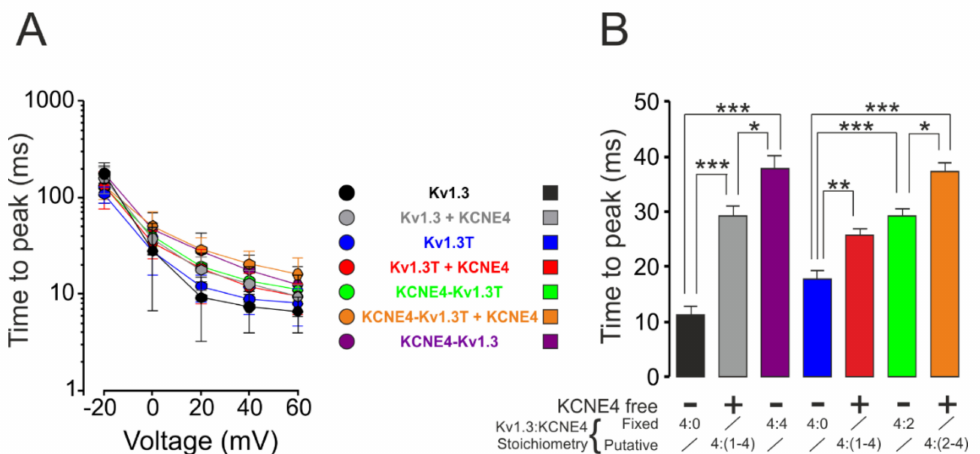
Figure 4. Analysis of Kv1.3 activation kinetics. HEK-293 cells were transfected with di ff